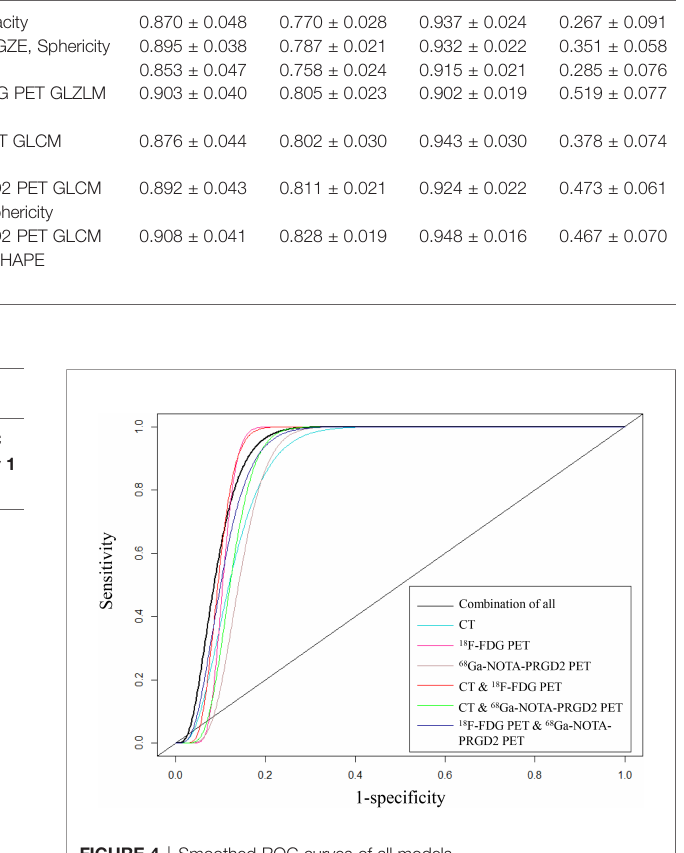
FIGURE 4 | Smoothed ROC curves of all